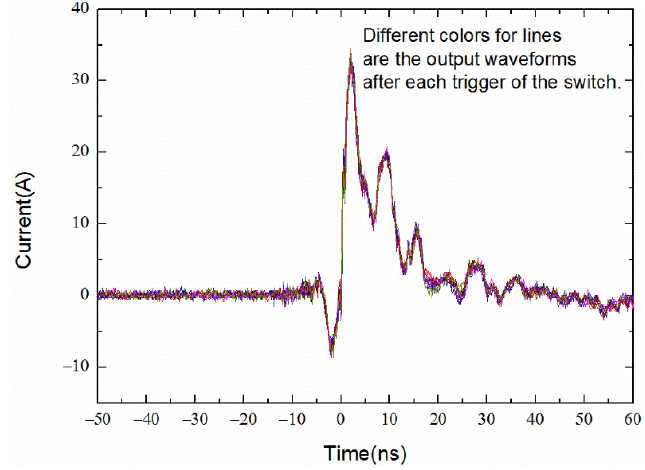
Figure 9. Ten repetitive output waveforms of the 10 mm GaAs PCSS biased at 30 kV.